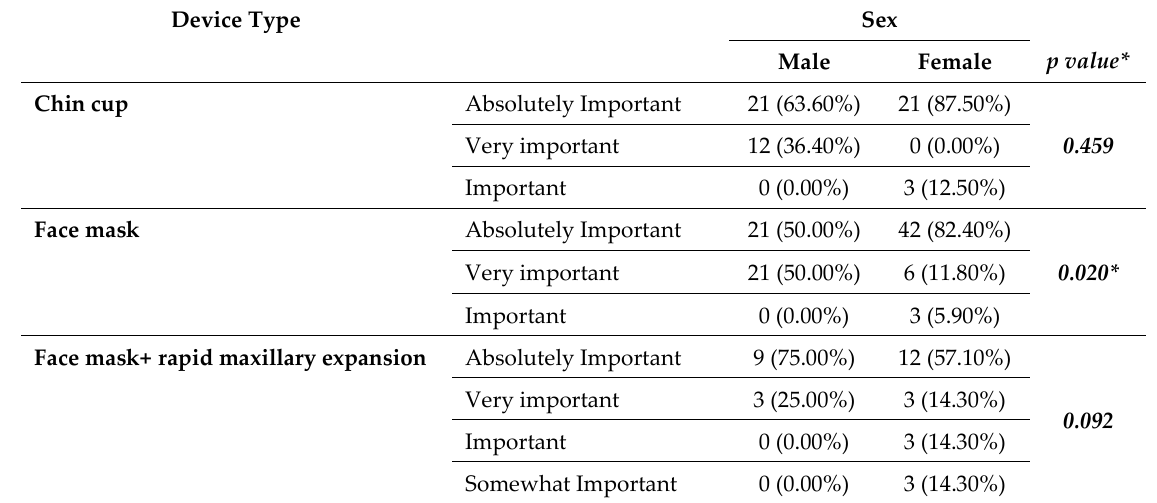
Table.3 : Importance of occlusion according to sex and device types